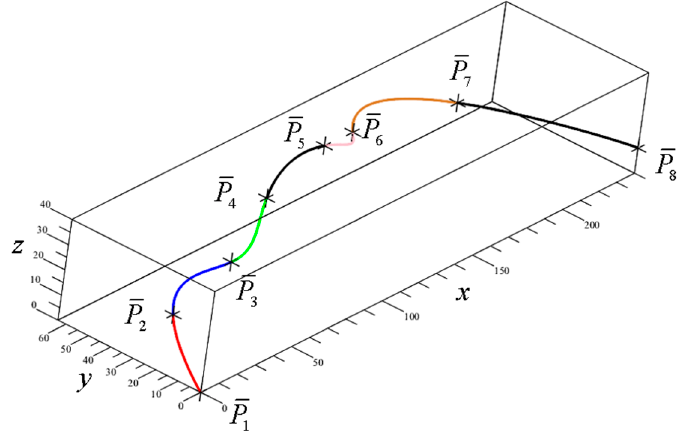
Figure 9. Fifth-degree Hermite spline curve of seven segments. Table 2. Curvature and torsion values at boundary points of the segments.